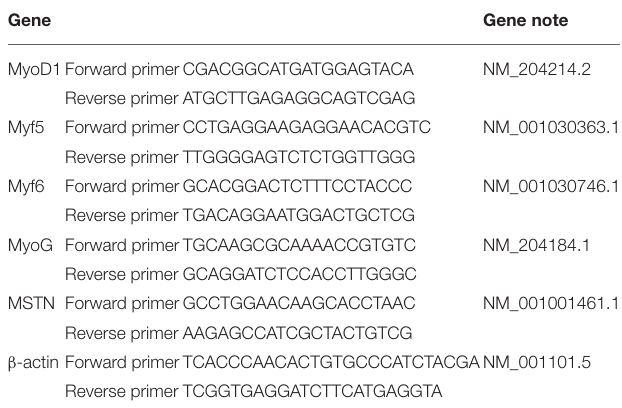
TABLE 1 | Primer for reverse transcription-PCR (RT-PCR) amplification.